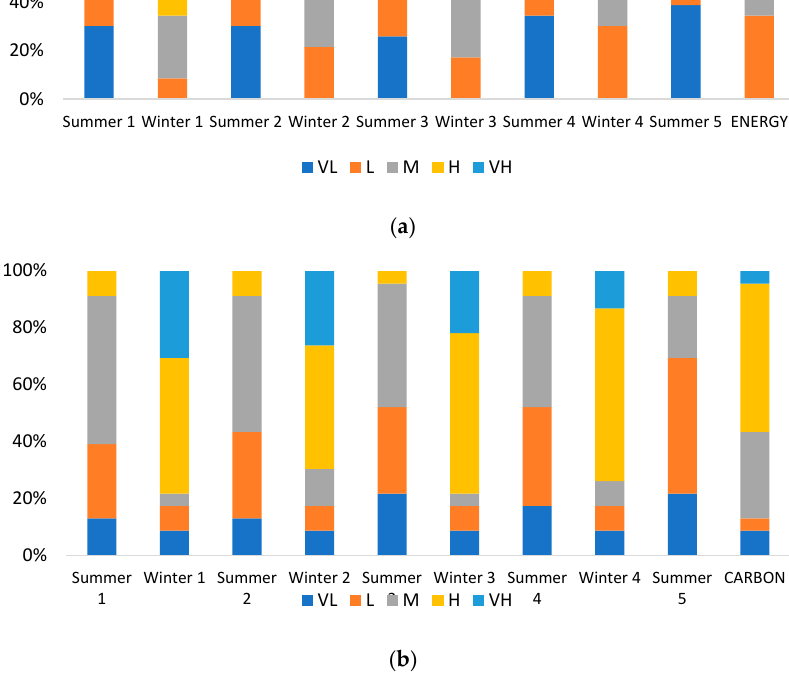
Figure 10. Temporal preference scenarios: ( a ) Energy, ( b ) carbon.